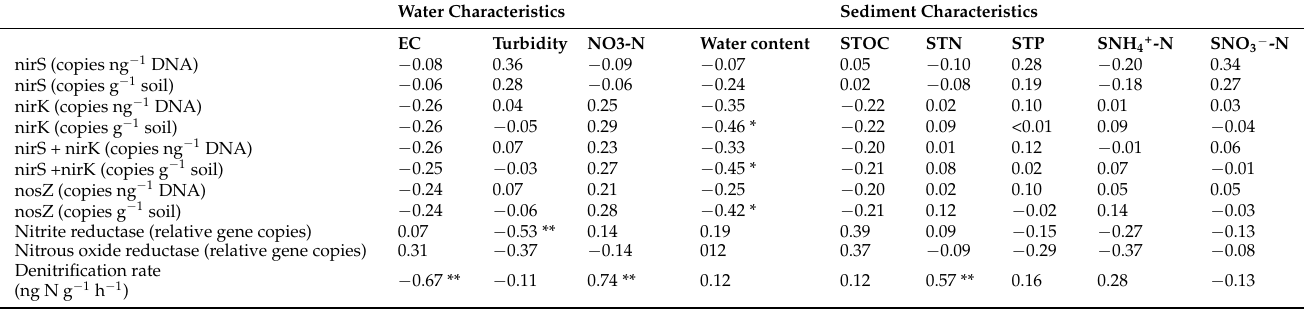
Table 4. Pearson correlation coefficients between denitrification factors (denitrifier abundances, enzyme activities, and denitrification rates) and water and sediment characteristics. * significant level < 0.05; ** significant level < 0.01.